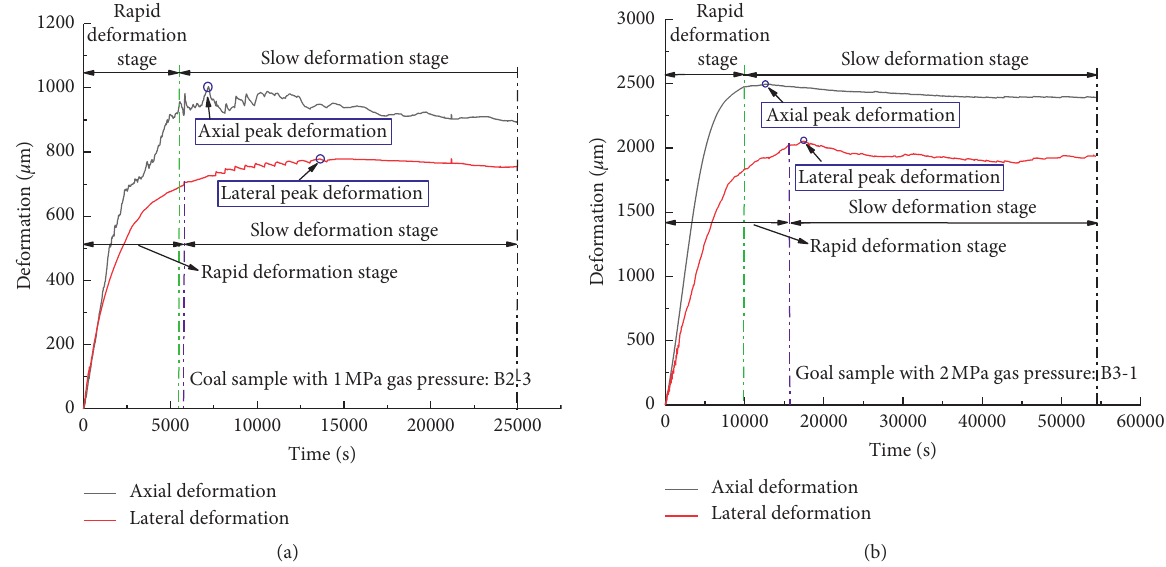
Figure 6: The deformation figure of the coal sample in the stable process. (a) Coal sample with 1MPa gas pressure. (b) Coal sample with 2MPa gas